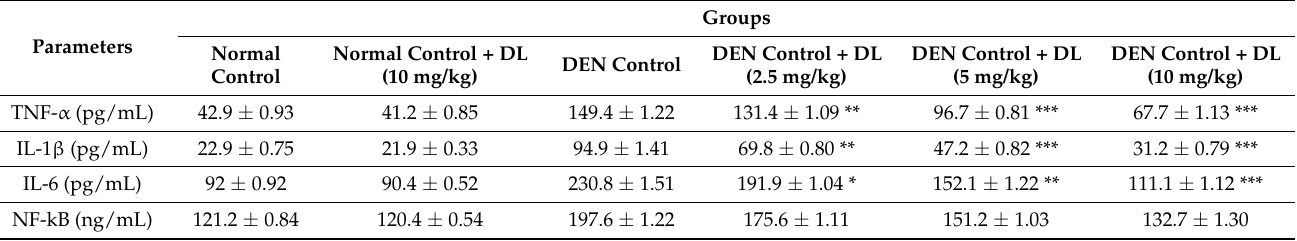
Table 6. Effect of DL on proinflammatory